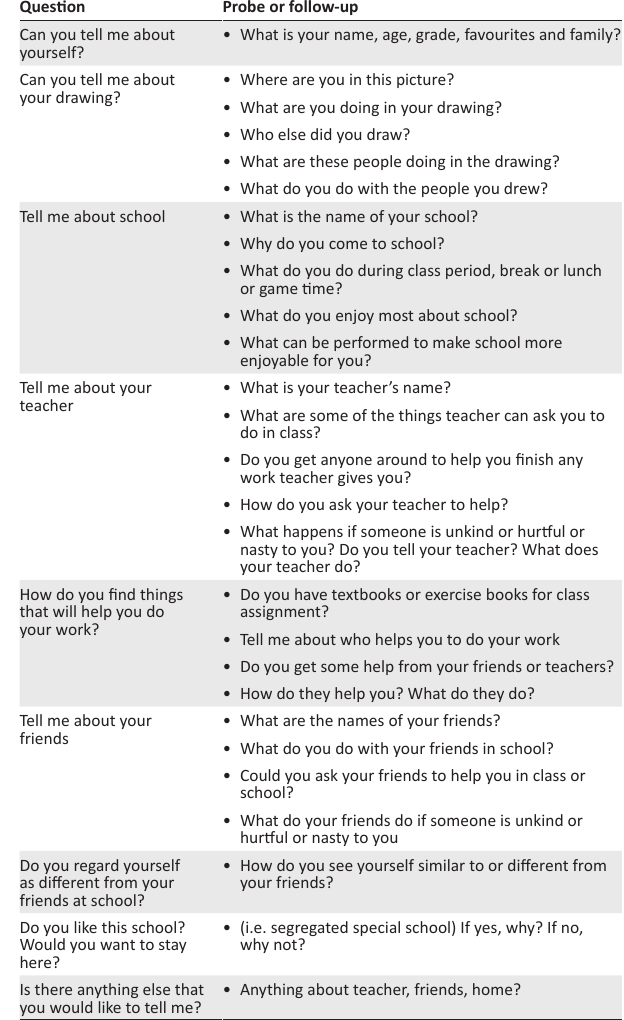
FIGURE 1: Observation guide.